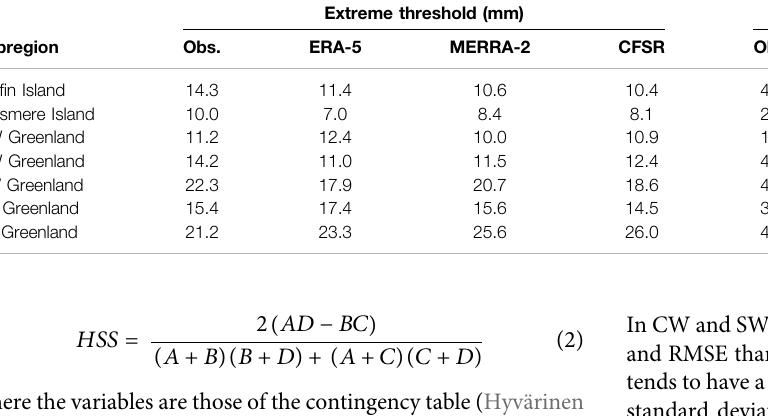
TABLE3| Extremedailyaccumulationthresholdsandtheeventfrequencyforeachsubregionrelativetotheobservationalthreshold.Extremethresholdsarethemeanofthe individual thresholds from each station in the region weighted by the station ’ s number of observations. Extreme threshold